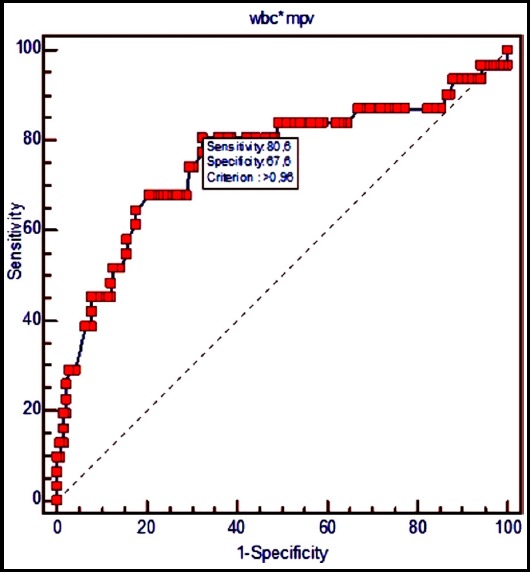
Sensitivity and specificity of WMR variable for predicting SYNTAX score ≥23.